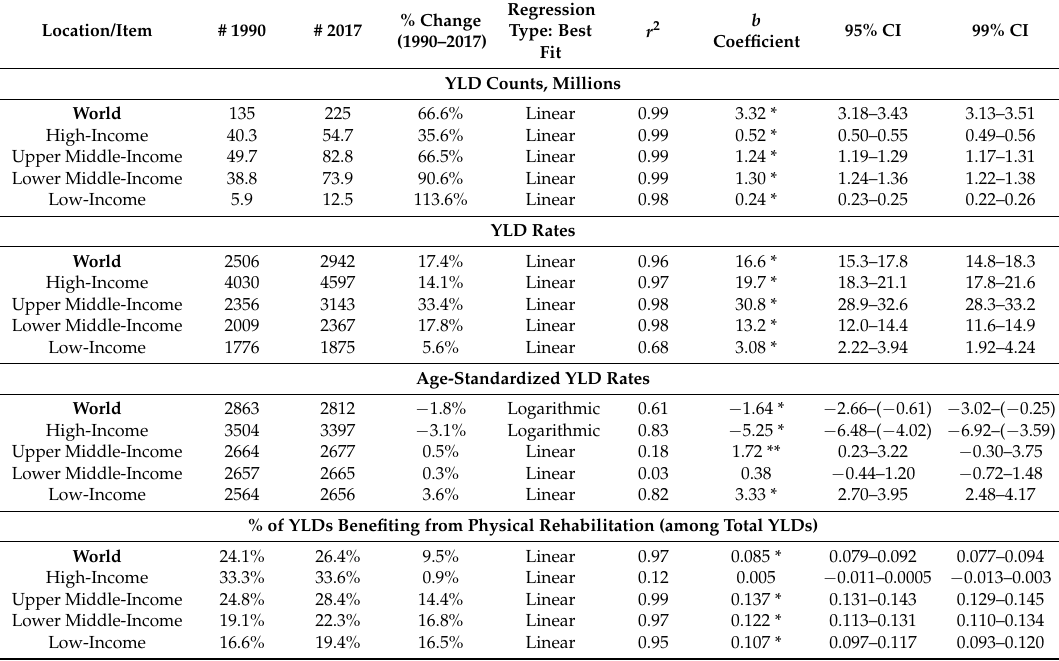
Figure 1. Percentage of YLDs Benefiting from Physical Rehabilitation among Total YLDs for the globe and across countries of varying income level. Linear regression lines (dotted) displayed. Table 4. YLDs from a narrow set (i.e., subgroup) of health conditions benefiting from Physical Rehabilitation